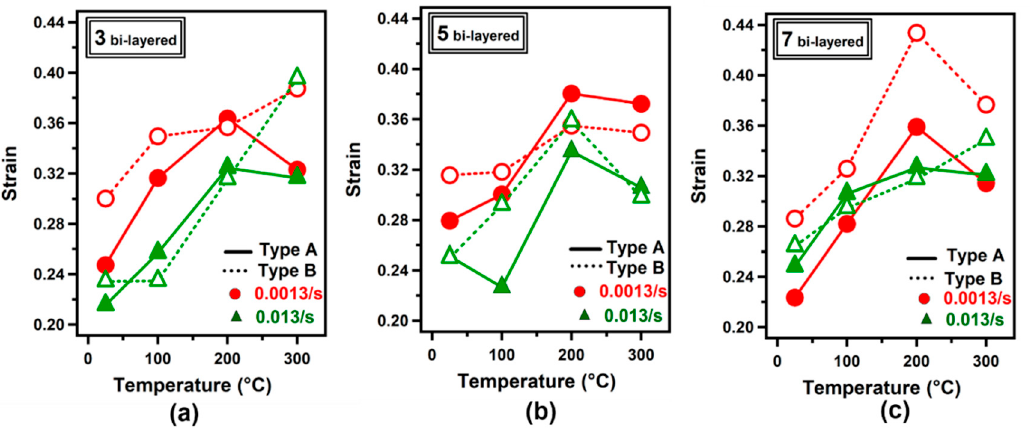
Figure 6. Strain-temperature variation based on tensile tests: ( a ) three bi-layered, ( b ) five bi-layered and ( c ) seven bi-layered composites.